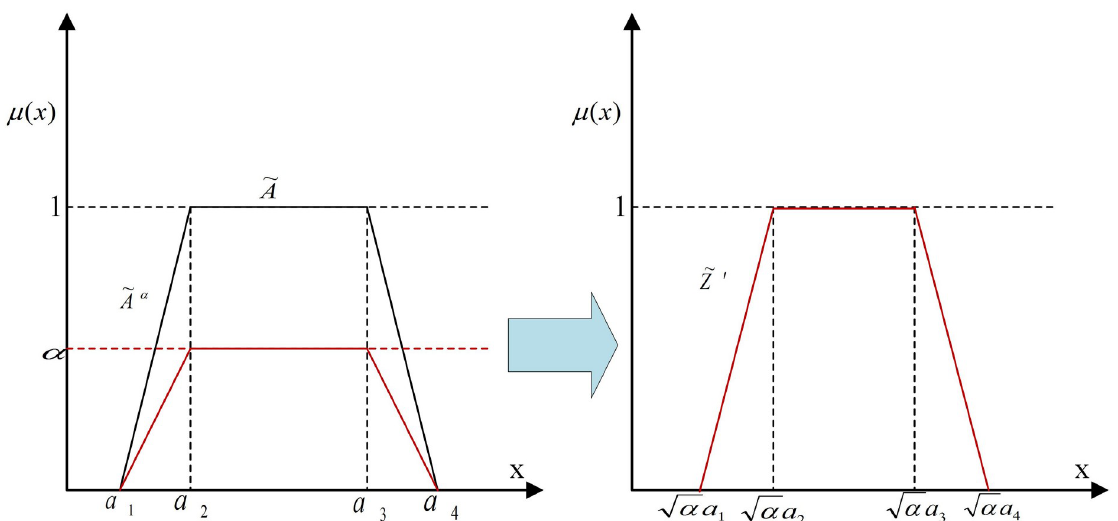
Fig 3. Transforming of Z-number to Fuzzy number. α is crisp value of reliability side of Z-number. A ~ is the left side of Z-number and Z ~ 0 is the final normal Fuzzy number.